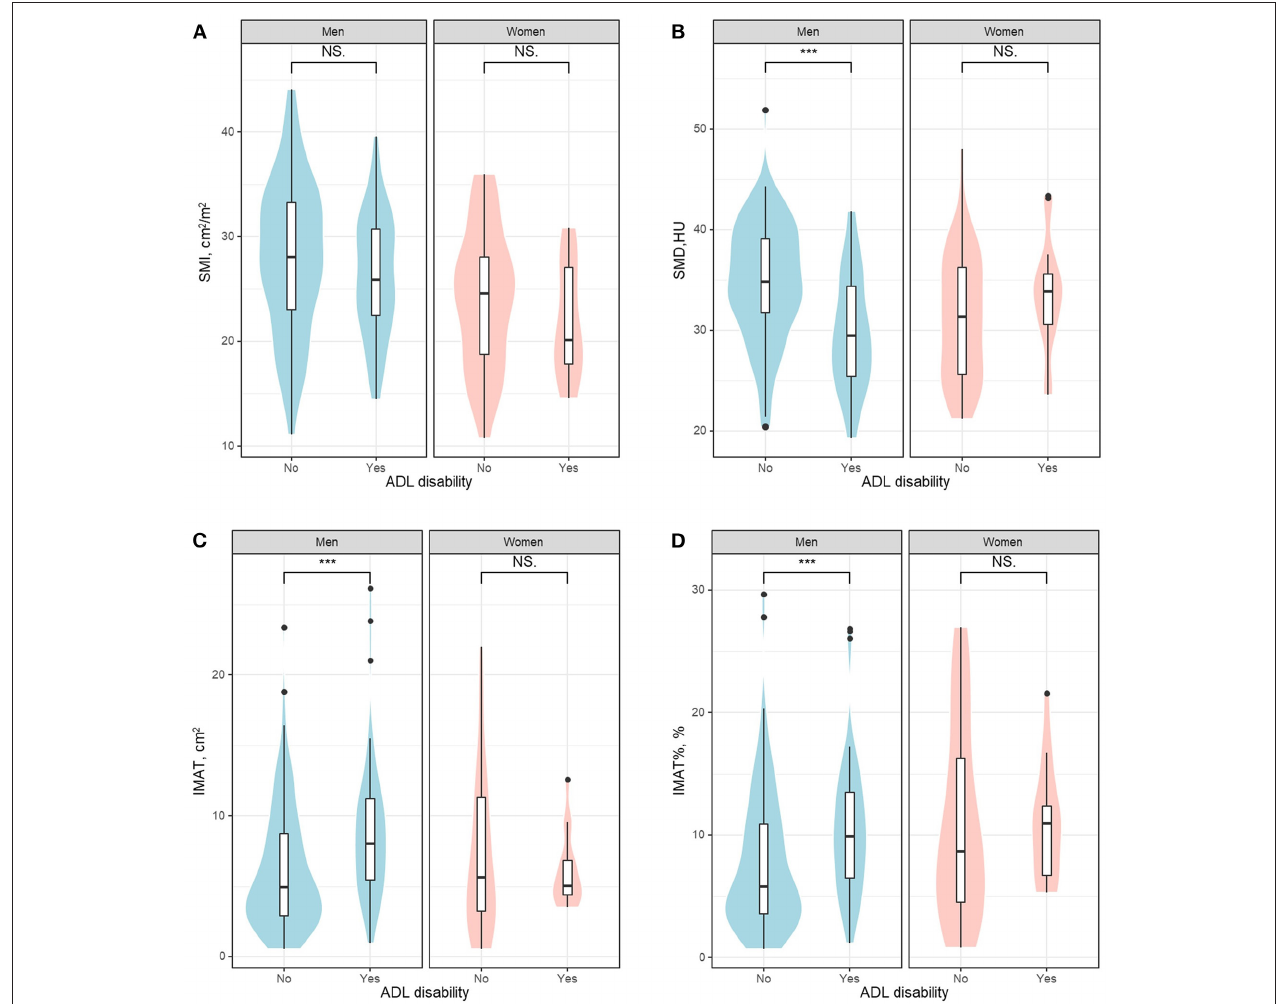
FIGURE 2 | The violin plot and boxplot of SMI (A) , SMD (B) , IMAT (C) , and IMAT% (D) between patients with or without ADL disability. ADL, activities of daily living; HU, Hounsfield unit; IMAT, intermuscular adipose tissue; IMAT%, percentage of intermuscular adipose tissue; NS, not significant; SMD, skeletal muscle radiodensity; SMI, skeletal muscle index. ***indicates P <